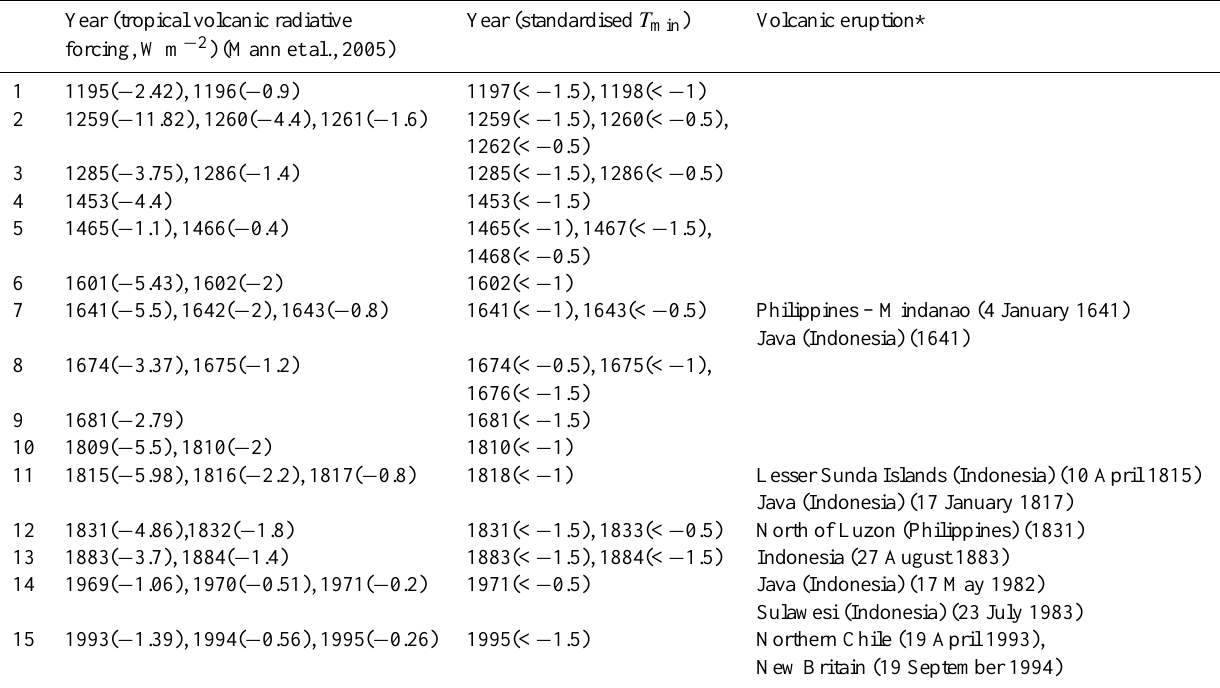
Table 4. Tropical volcanic eruptions and the possible corresponding cold events recorded by tree rings (AD 1000–1999). Year (tropical volcanic radiative Year (standardised T min ) Volcanic eruption* forcing, Wm − 2 ) (Mann et al.,